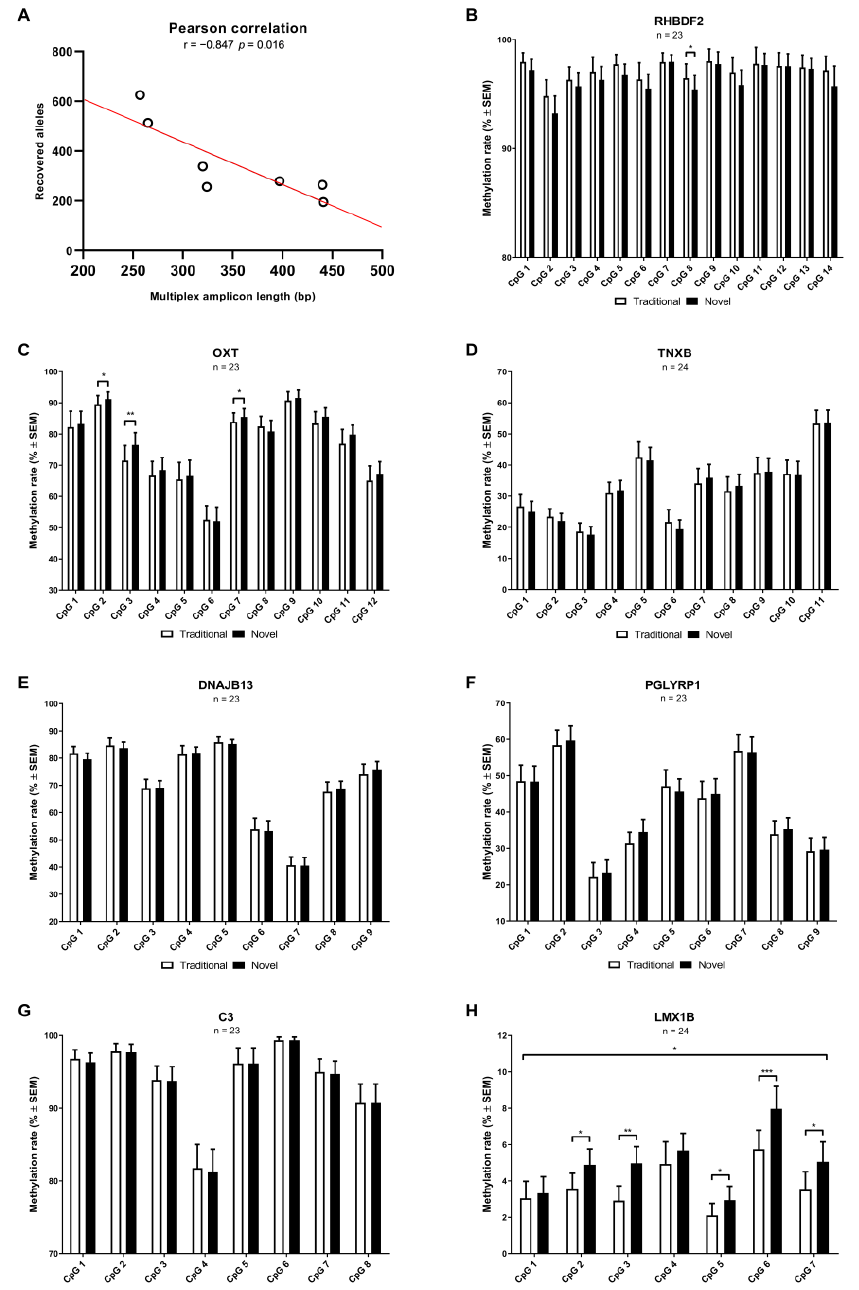
Figure 2. ( A ) Displayed is the Pearson correlation test was performed to assess whether there was a correlation between the number of recovered alleles and multiplex amplicon length of each gene. ( B – H ) Shown for each target gene are the paired cytosine-phosphate-guanine (CpG) methylation rates (mean percentage ± standard error of the mean [SEM]) estimated by both the traditional and novel downstream data analysis for limiting dilution bisulfite pyrosequencing (LDBSP) on pools of 50 neurons. A one-way repeated measures multivariate analysis of variance (MANOVA) was performed in order to determine whether there was a combined significant difference in the CpG methylation rates estimated by both methods. Subsequently, a univariate analysis was performed in order to identify differences between the methylation rates for each individual CpG site. A p -value of <0.05 was considered statistically significant. Significant findings for the multivariate and univariate tests are indicated with an asterix (* = p < 0.05; ** = p < 0.01; *** = p < 0.001). Based on the final allele estimations above, the CpG methylation rates, representing the percentage of methylated CpG sites from the total number of recovered alleles per gene, were calculated per individual. An overview of the average CpG methylation rates